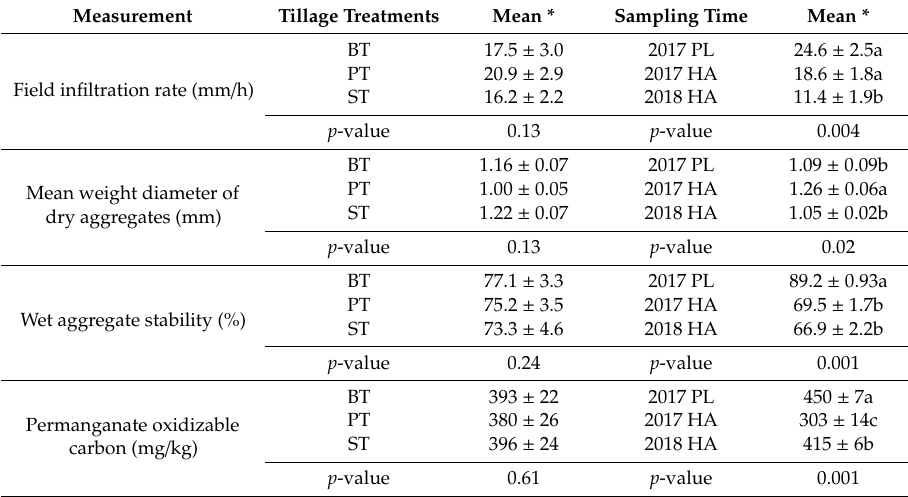
Table 5. Soil measurements under the tillage treatments tested in Las Cruces (2017 and 2018).